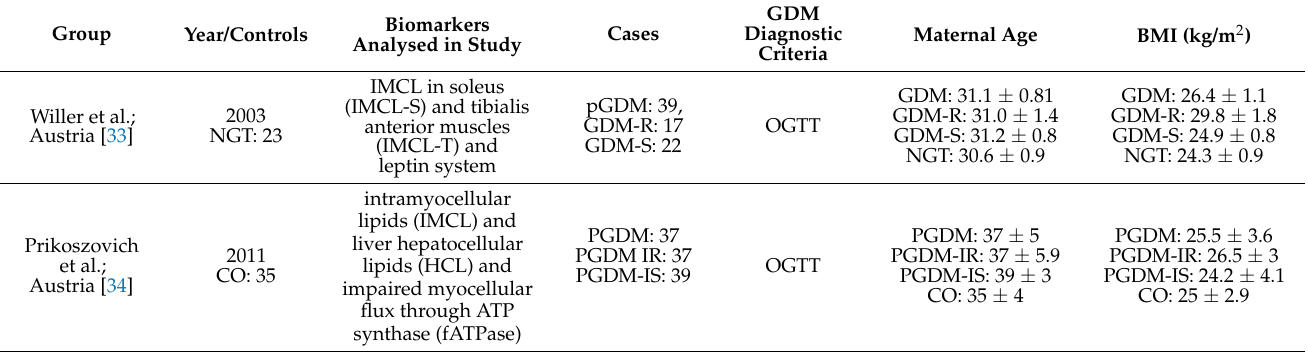
Table 3. Summary of GDM Selected Studies General Characteristics and Outcomes of